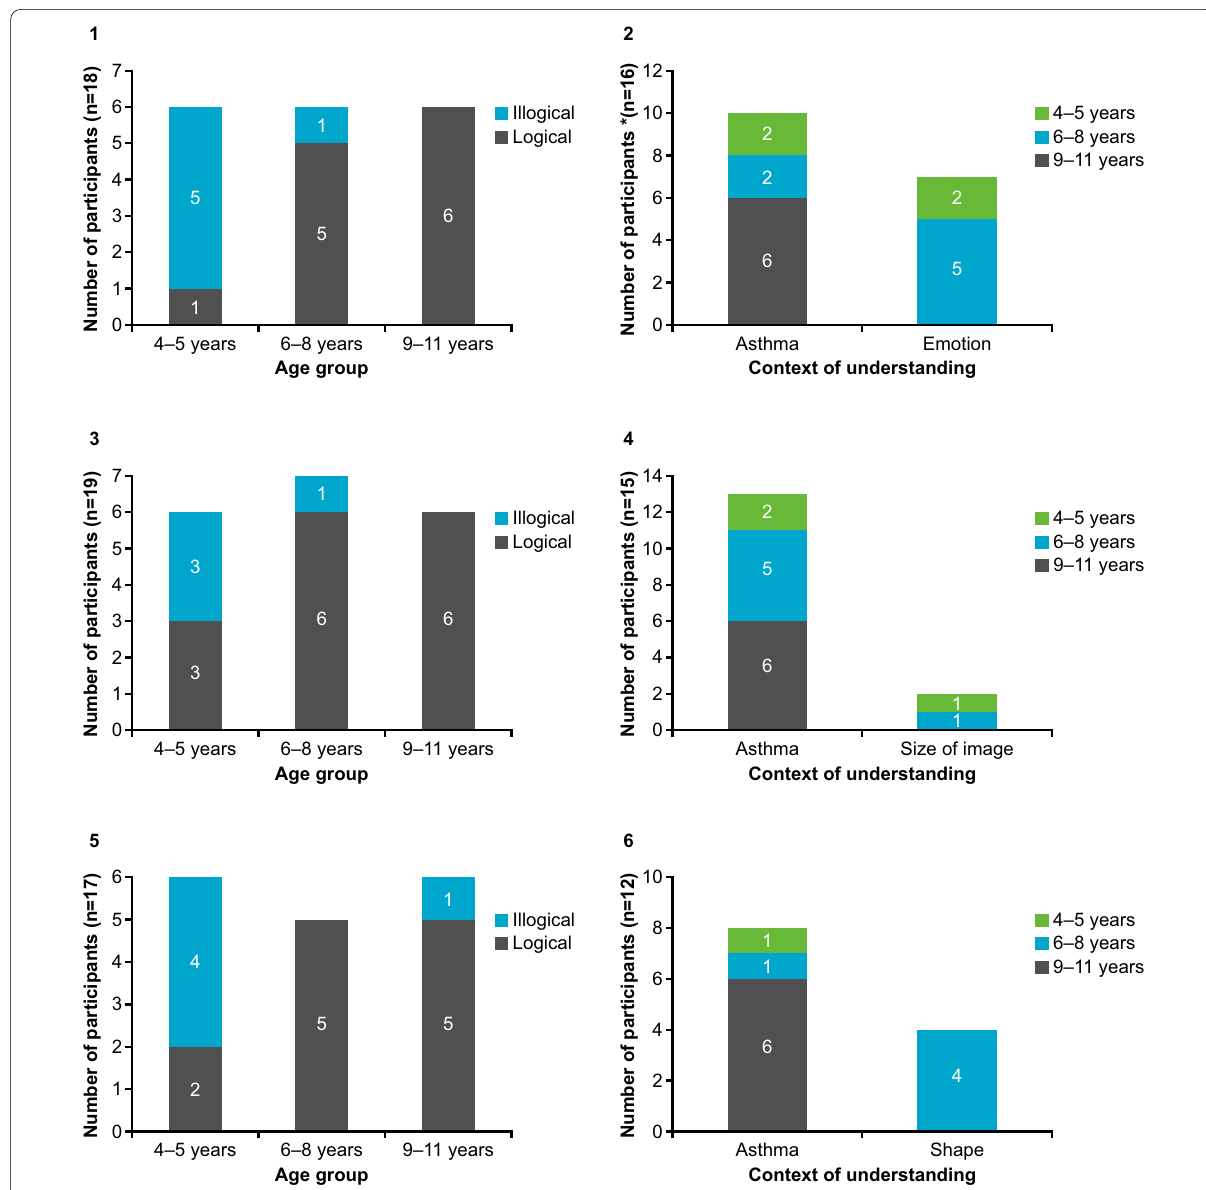
Fig. 4 Stage 1 logical and illogical ranking and context of understanding. 1 Scale A (logical and illogical ranking); 2 Scale A (context of understanding); 3 Scale B (logical and illogical ranking); 4 Scale B (context of understanding); 5 Scale C (logical and illogical ranking); 6 Scale C (context of understanding). Logical and illogical ranking: represents the number of patients who ranked the options in a logical sequence. Context of understanding: for scale A conveyed understanding both in the context of asthma and the emotions portrayed by the image; for scale B conveyed their understanding in the context of their asthma and the size of the images; for scale C conveyed understanding both in the context of asthma and the shape of the